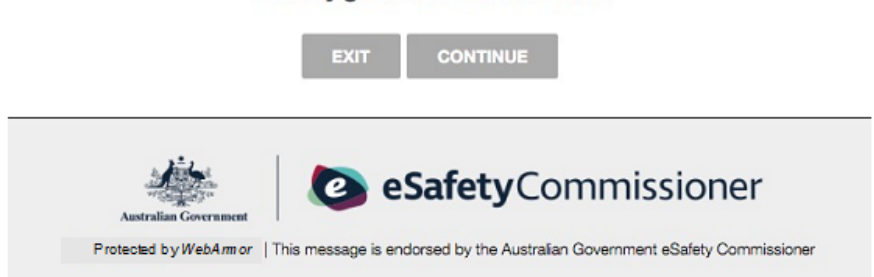
Figure 4. Examples of the messages shown during second experiment, which focused on dissuad- ing users from sharing illegal content. users from sharing illegal